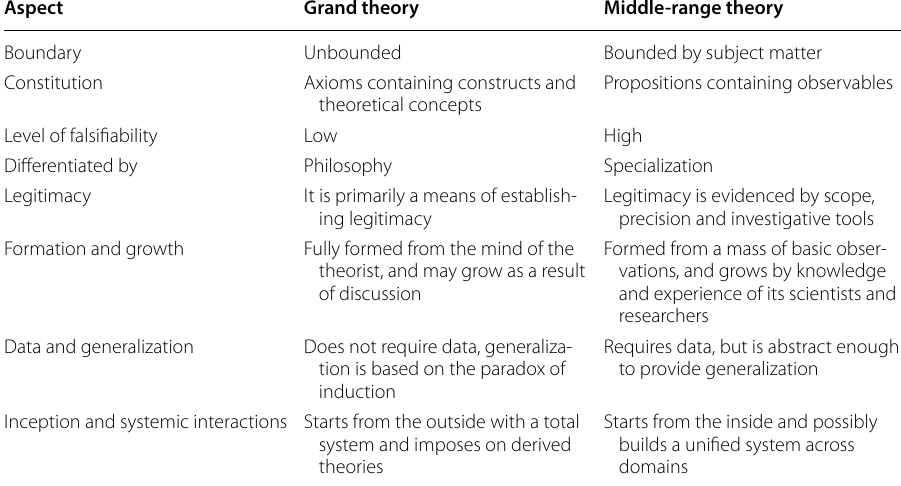
Table 2 Differences between Grand and Middle-range theories [18, p.